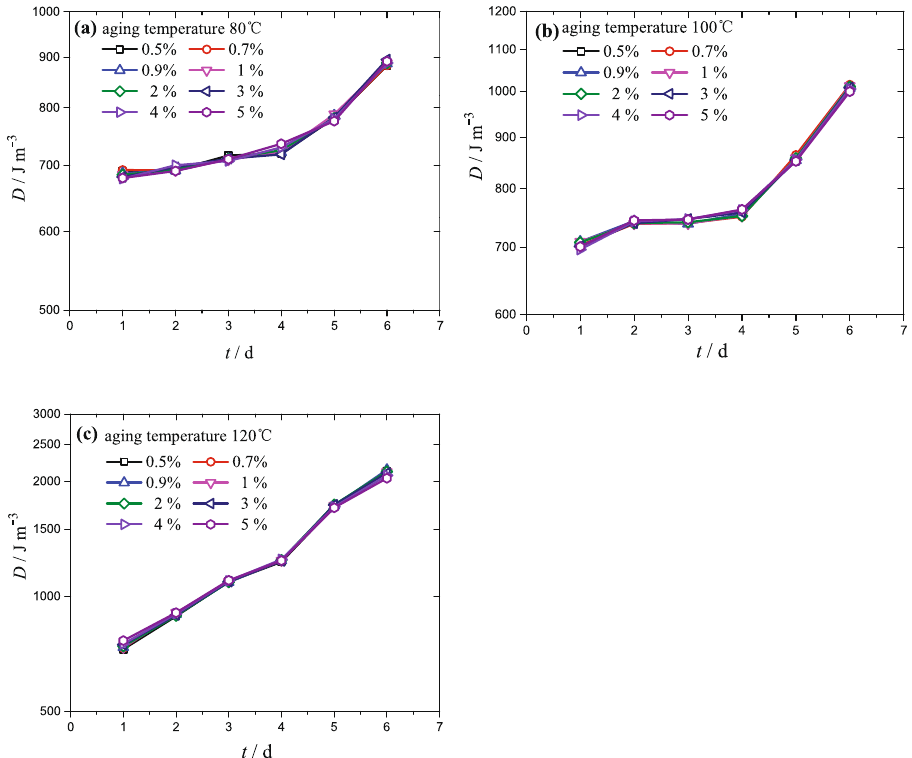
Fig. 7 Master curve of hysteresis loss. The master curve at a reference dynamic strain amplitude of 1% has been constructed by vertically shifting the curves at other strain amplitudes for various aging temperatures: a 80 ℃ , b 100 ℃ and c 120 ℃ .